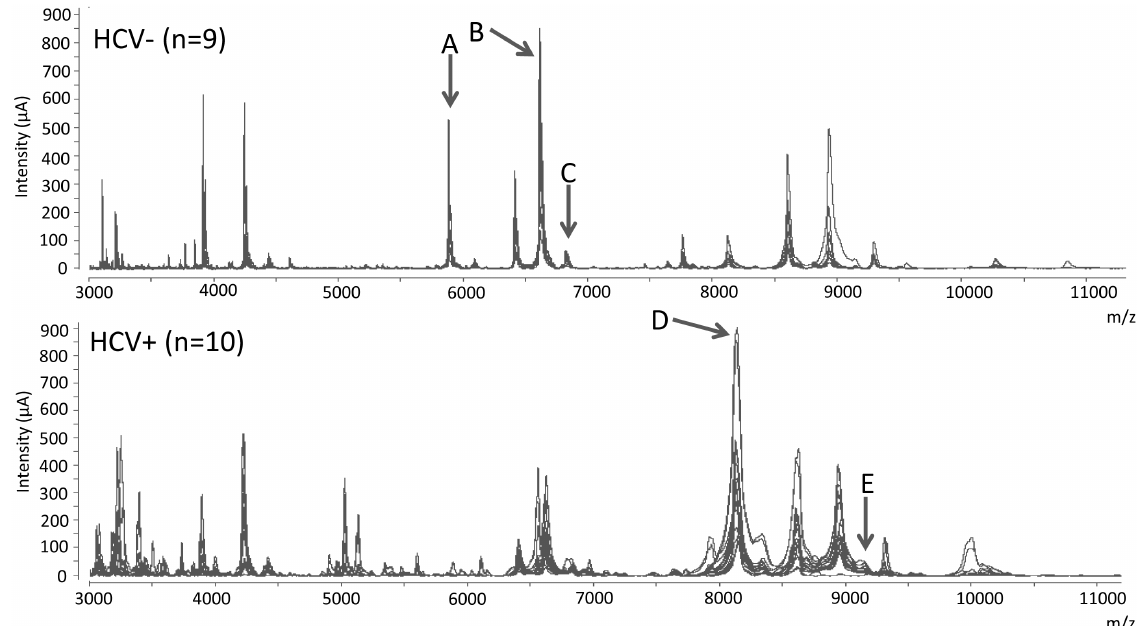
Figure 1. Differential proteomic profile between HCV 2 and HCV + patients submitted to LT. Fragment ranging from 3000 to 11000 m/z of the differential SELDI-TOF-MS spectra of all serum samples obtained from patients 6 months after LT. The upper figure shows all overlapped spectra from HCV-negative patients (n=9). The bottom figure shows the spectra from HCV-infected patients (n=10). Arrows indicate peaks showing significantly different intensities between HCV 2 and HCV + patients. Upper letters correspond to the identification peak noted in table 2.